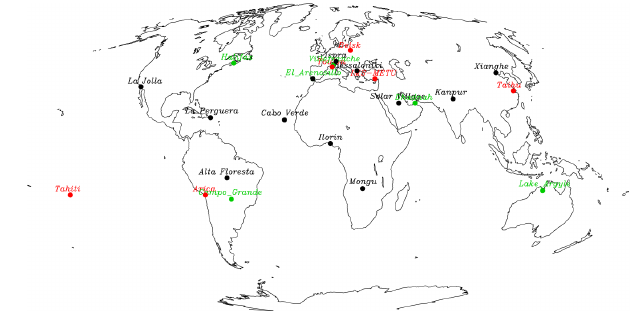
Figure 12. Location of the AERONET stations presented in Fig. 13 with names in black and in Fig. 15 with names in red for poor per- formance and in green for good